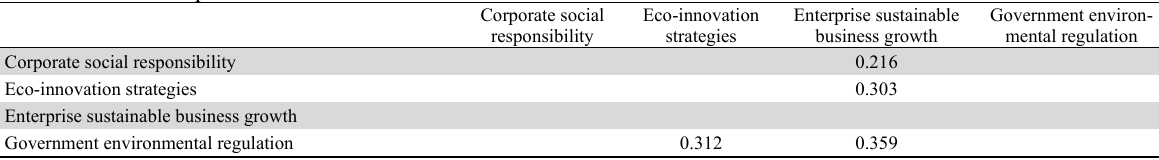
The results of the f